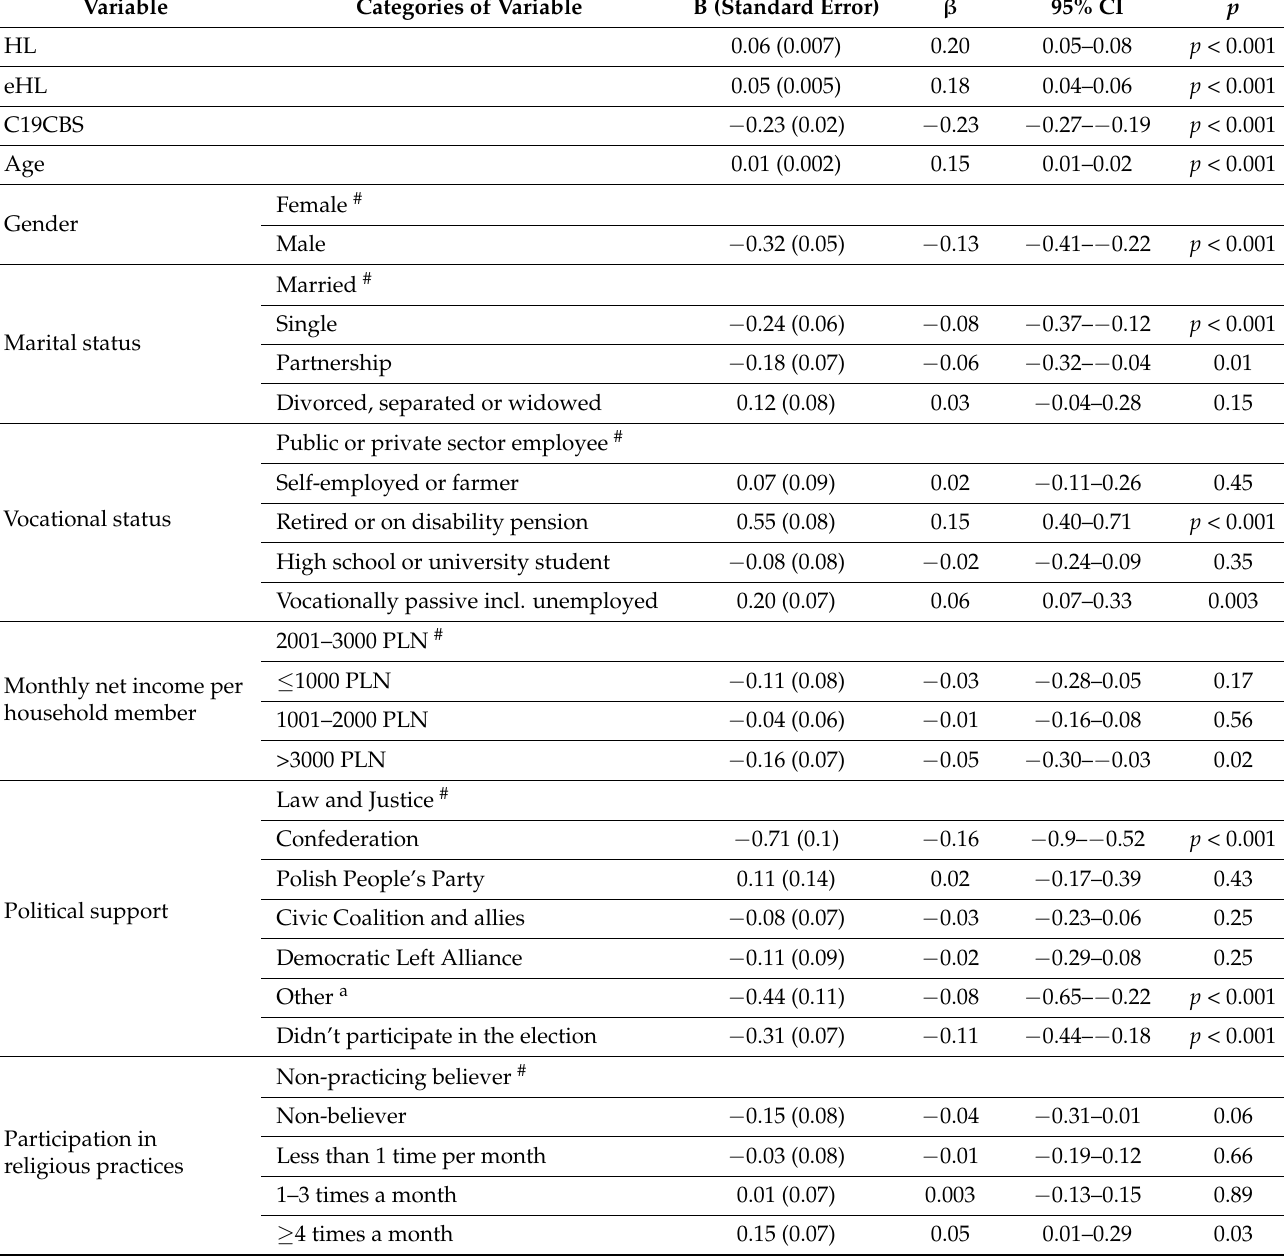
Table 4. Univariable linear regression models for the preventive measures